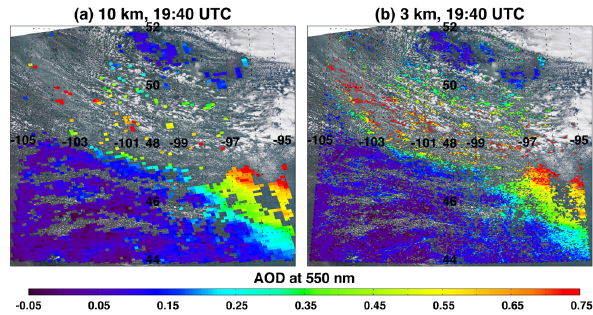
Fig. 3. Aerosol optical depth at 550nm retrieved from the 15 July 2010 Aqua-MODIS radiances using the Collection 6 MODIS Dark Target aerosol algorithm. Left: the product at 10km resolution. Right: the product at 3km resolution. The situation is a moderate dust event over the Mediterranean Sea off the costs of Tunisia and Libya. The 3km retrieval produces values closer to the coastline and to the islands.